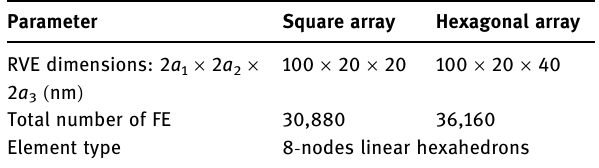
Table 2: Numerical model